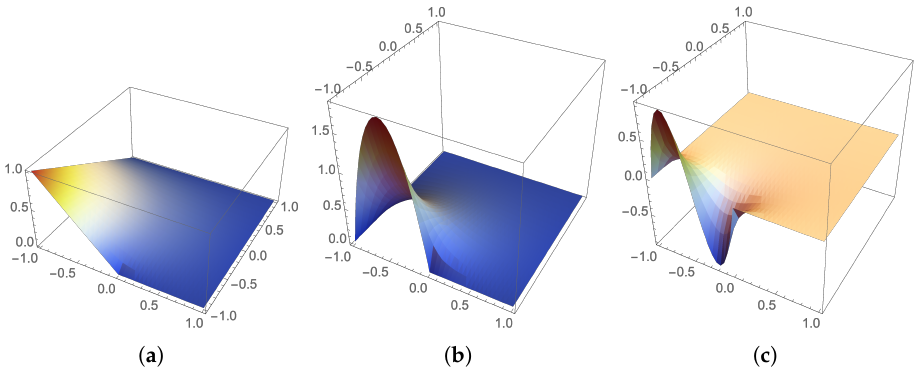
Figure 3. Quadrilateral. ( a ) Nodal mode. ( b ) Edge mode with p = 2. ( c ) Edge mode with p =